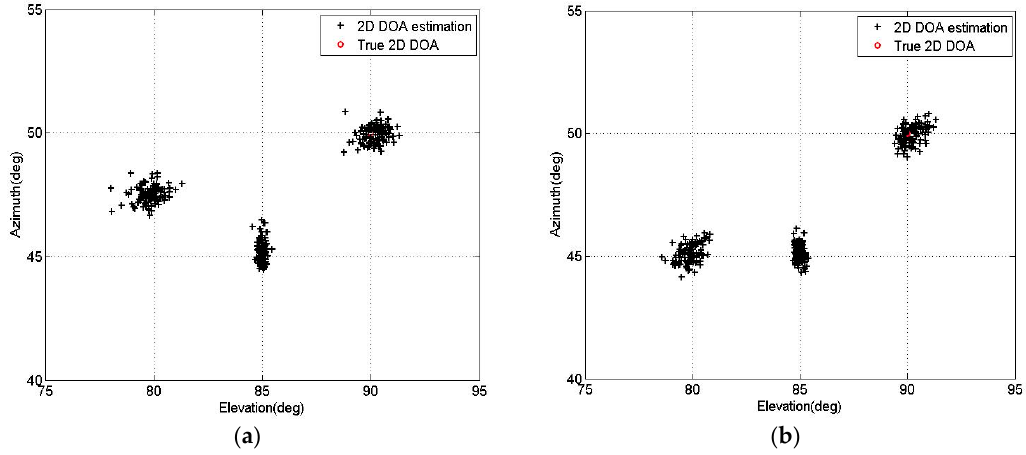
Figure 8. 2D DOA Estimation results of proposed BCM-AMM algorithm. ( a ) Three signals with different elevation and azimuth angles; ( b ) Two signals with the same azimuth angles.